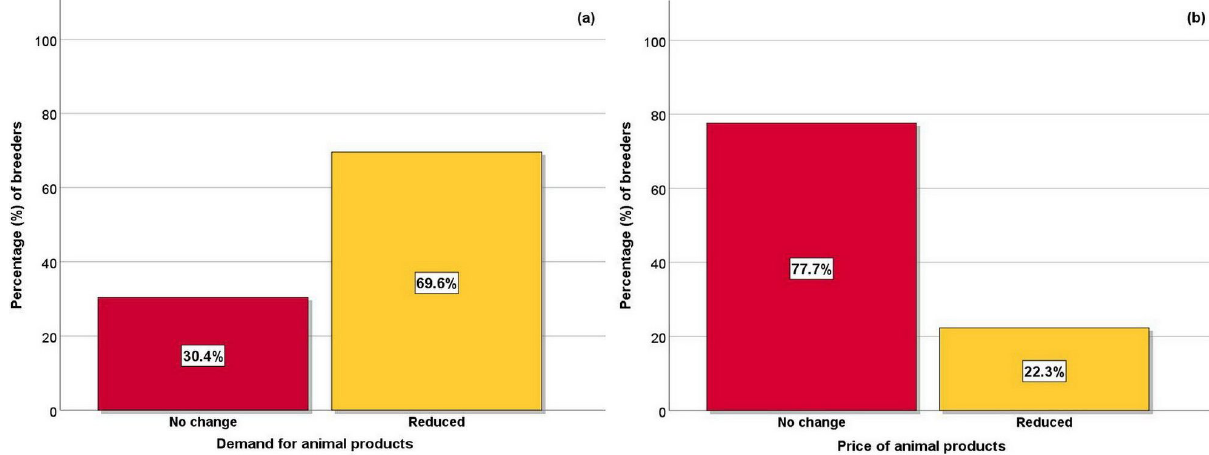
Figure 4. Percentage (%) of small ruminant breeders who observed a reduction in the (a) demand for animal products and the (b) price of animal products during the COVID-19 restrictive measures.